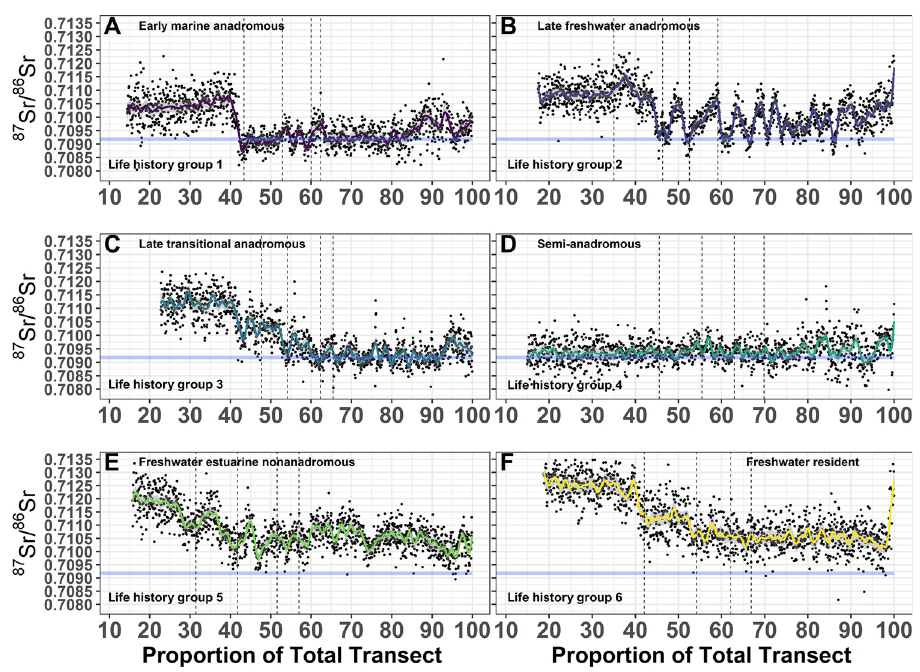
Fig 4. Broad Whitefish life history examples. Selected otolith 87 Sr/ 86 Sr profiles for six Broad Whitefish ( Coregonus nasus ) from the Colville River, AK, USA, representative of each life history type. Fitted Generalize Additive Model values (solid-colored lines), 95% confidence interval (grey shading), and raw 87 Sr/ 86 Sr for each life history type (black dots) from the otolith core to edge are shown. Life history types shown; early marine anadromous (A), late freshwater anadromous (B), late transitional anadromous (C), semi-anadromous (D), freshwater estuarine nonanadromous (E), freshwater resident (F). Thin dashed vertical black lines represent the end of each winter annular growth (annuli) for the first four years. The horizontal light blue line represents the global mean oceanic value (GMV = 0.70918 ± 0.00006 2